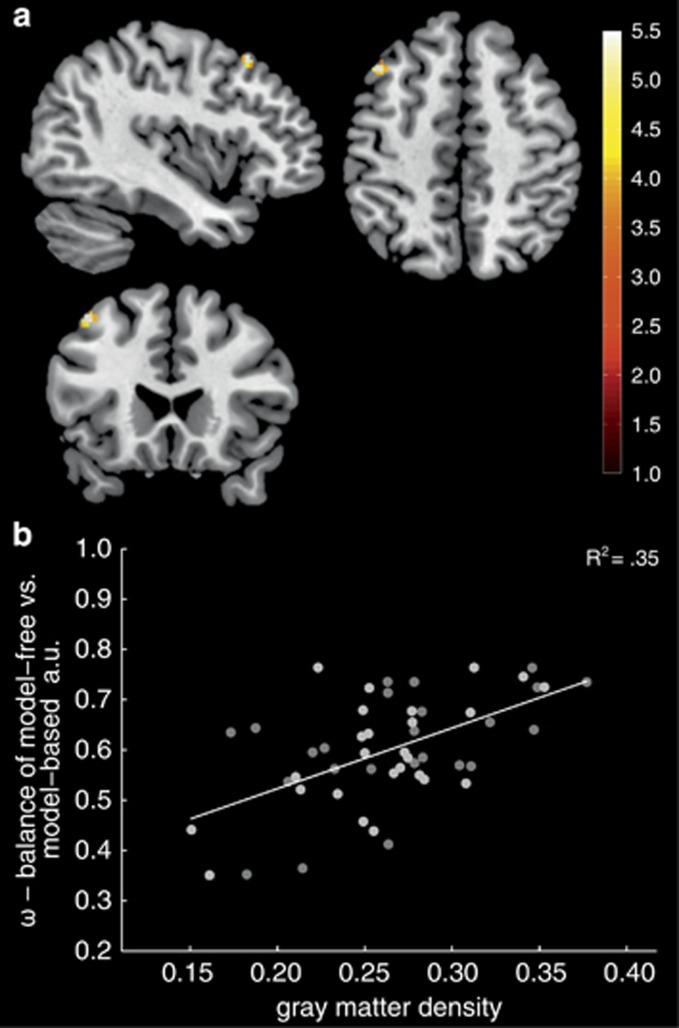
Gray matter density and the balance of behavioral control. (a) A positive correlation between gray matter density in the dorsolateral prefrontal cortex (PFC; Montreal Neurological Institute (MNI) x=−42, y=22, z=50, t=5.04, p-FWE=0.05 for bilateral medial and lateral PFC) and the balance of model-free and model-based control (ω) was observed. For display purposes, maps are thresholded at P<0.001 uncorrected and a cluster extent of k=20. (b) Scatterplot for illustration. FWE, family-wise error.